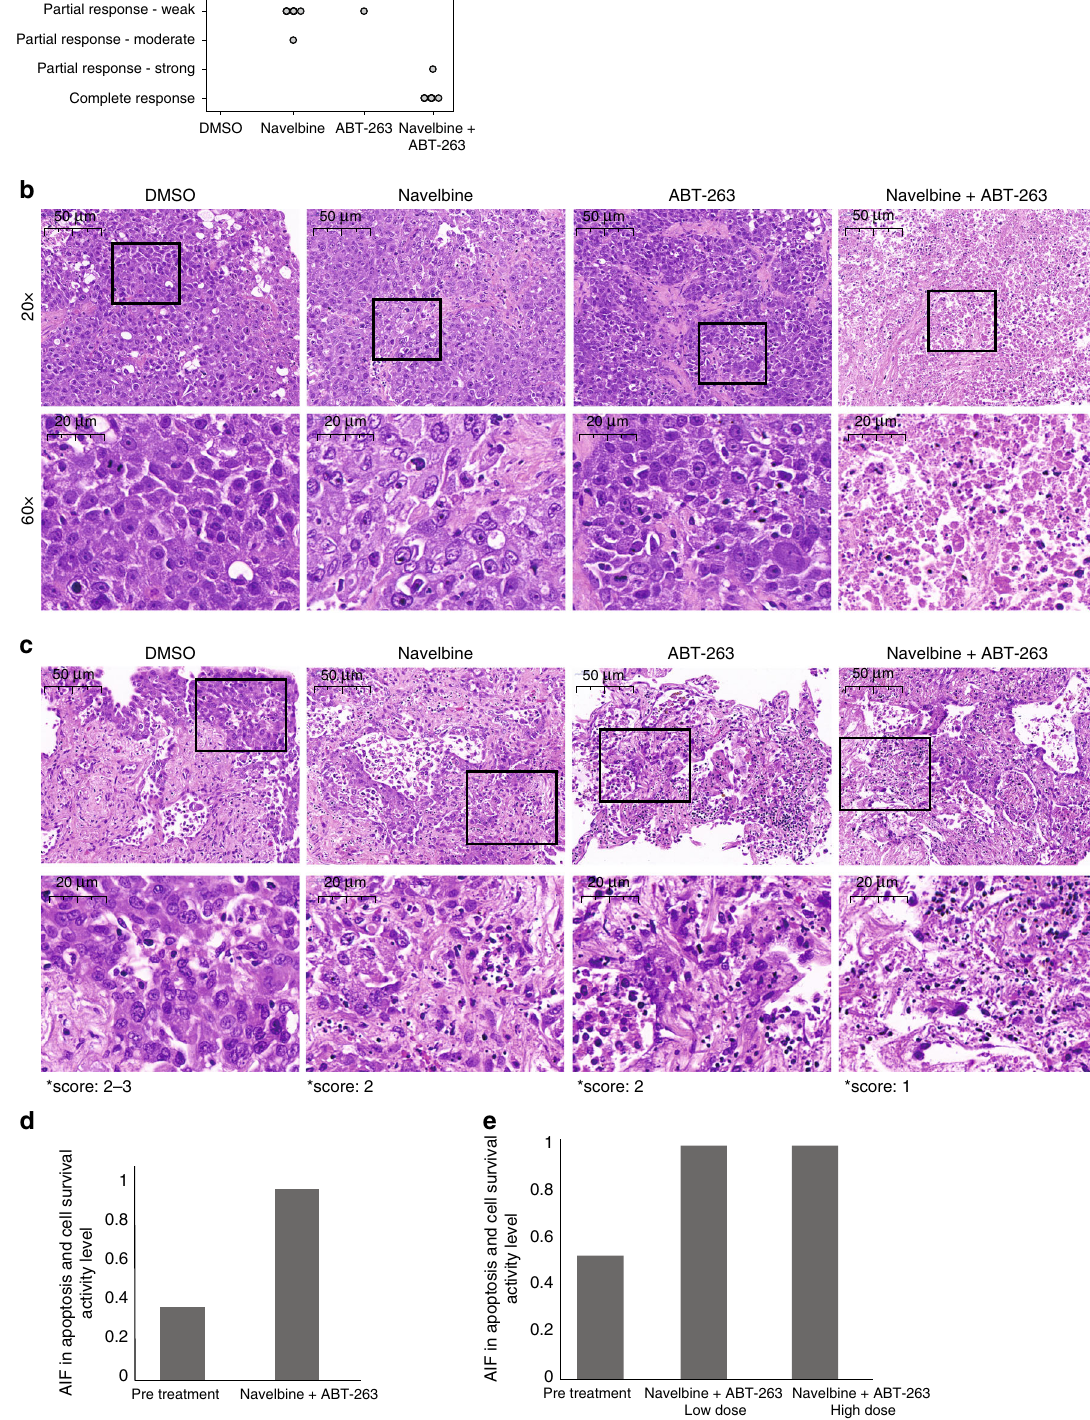
Fig. 5 Synergistic activity of ABT-263 and Navelbine in PDX-model and human lung cancer patient. a Cell viability in ex-vivo organ culture. Viability values are as follows: 0: 0 – 20% viability, complete response; 1: 20 – 35%, partial response: strong; 2: 36 – 59%, partial response: moderate; 3: 60 – 84%, partial response: weak; 4: 85 – 100%, no response. Viability percentages were quanti fi ed by evaluating morphological features and were performed by two pathologists that were blinded to the experiment. b H&E-stained histology of NSCLC PDX tumors treated ex-vivo with DMSO (control), Navelbine, ABT-263, and a combination of the two drugs. c H&E-stained histology of a tumor from an untreated 71-year-old patient. The samples treated ex-vivo with DMSO (control), Navelbine, ABT-263, and a combination of the two drugs. d AIF pathway activity levels calculated from qRT-PCR in FFPE-preserved tissues from ( b ). P -values were generated using Mann – Whitney U -test. e AIF pathway activity levels calculated from qRT-PCR in FFPE-preserved tissues from ( c ) before and after treatment with a combination of navelbine and ABT-263. P -values were generated using Mann – Whitney U -test. See also Supplementary Fig.